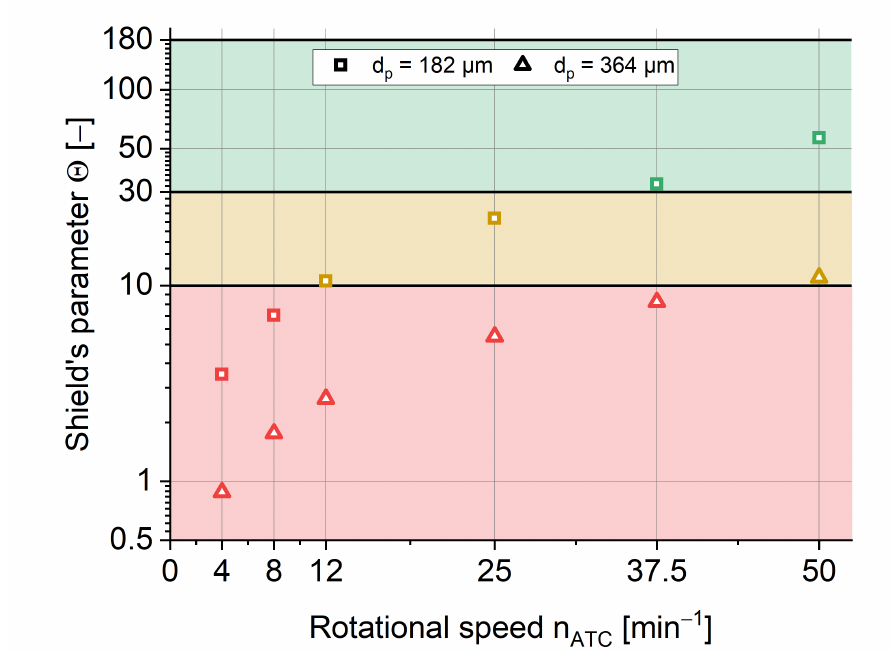
Figure 11. Rotational speed n ATC and Shield’s parameter Θ for selected particle sizes at filling degree (cid:101) = 0.25. Suspension states are classified according to Figure